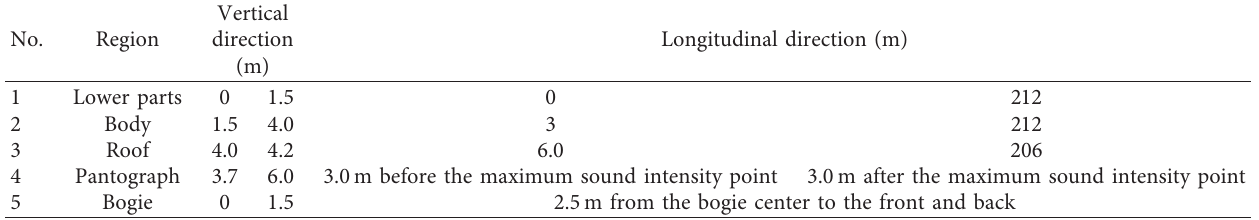
Table 2: Definitions of noise source regions of the train.